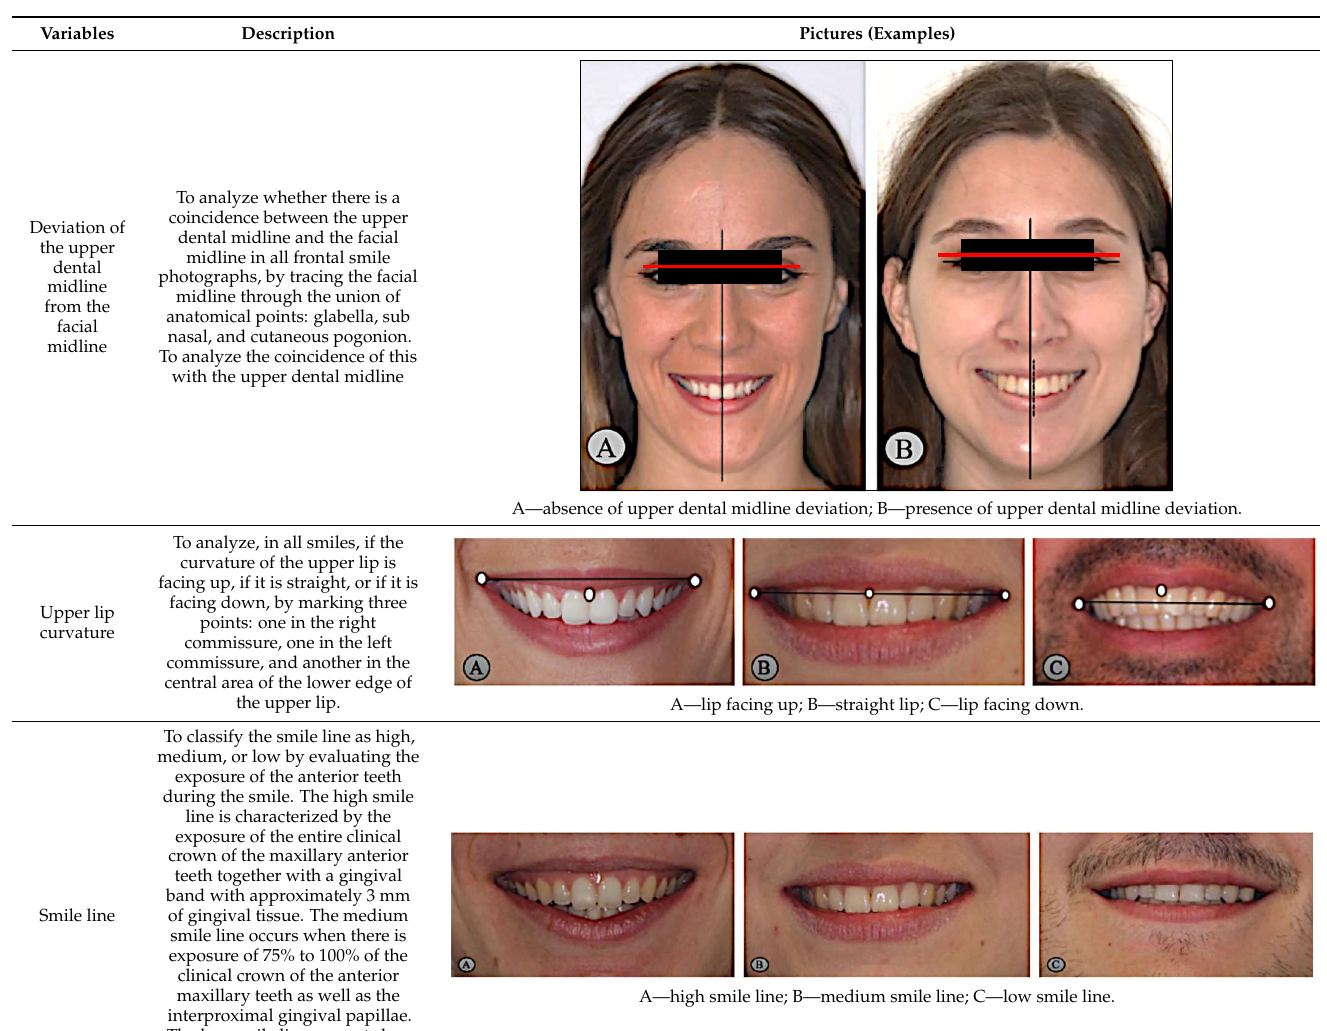
Table 1. Description of the esthetic parameters evaluated.